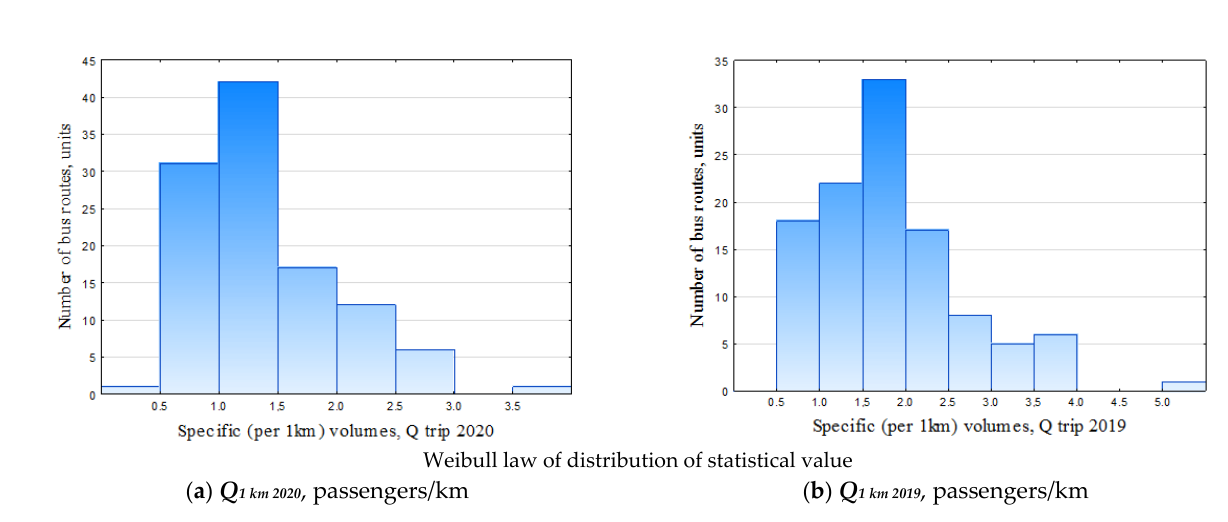
Figure 11. Distribution of values of the relative number of passengers transferred per 1 km of bus mileage Q 1 km on Tyumen CPPT bus routes in 2020 and 2019.